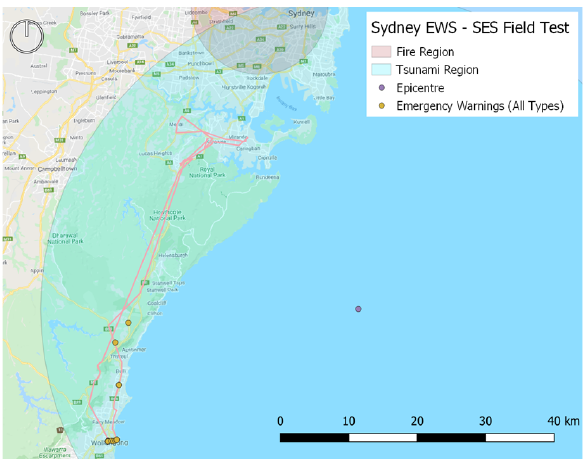
Figure 7. Route of the SES personnel during Sydney EWS test